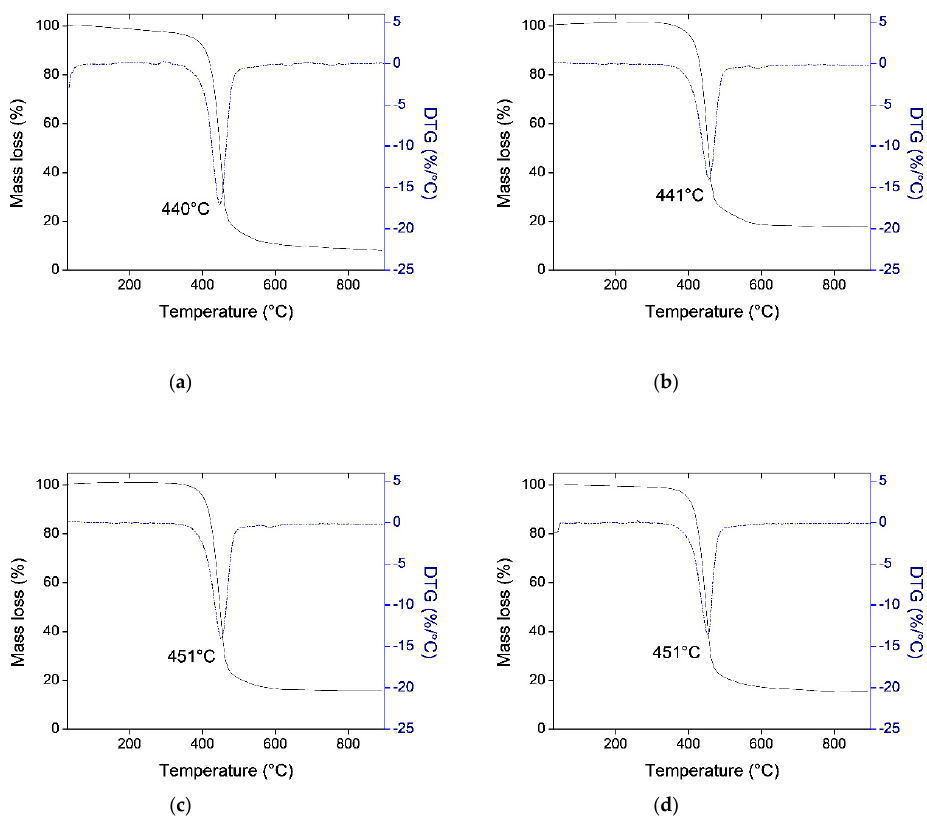
Figure 1. Thermogravimetric profiles of PdAS(x)-MA catalysts. ( a ) PdAS(1)-MA, ( b ) PdAS(2)-MA, ( c ) PdAS(5)-MA, and ( d ) PdAS(10)-MA.